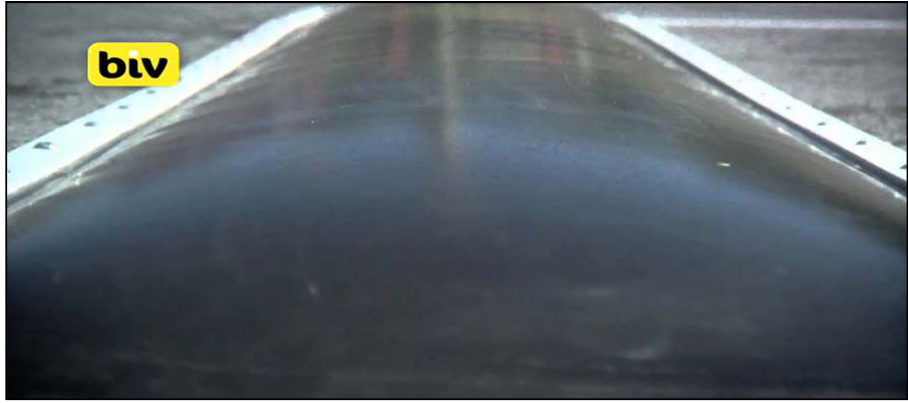
Figure 13. Badennova artificial road